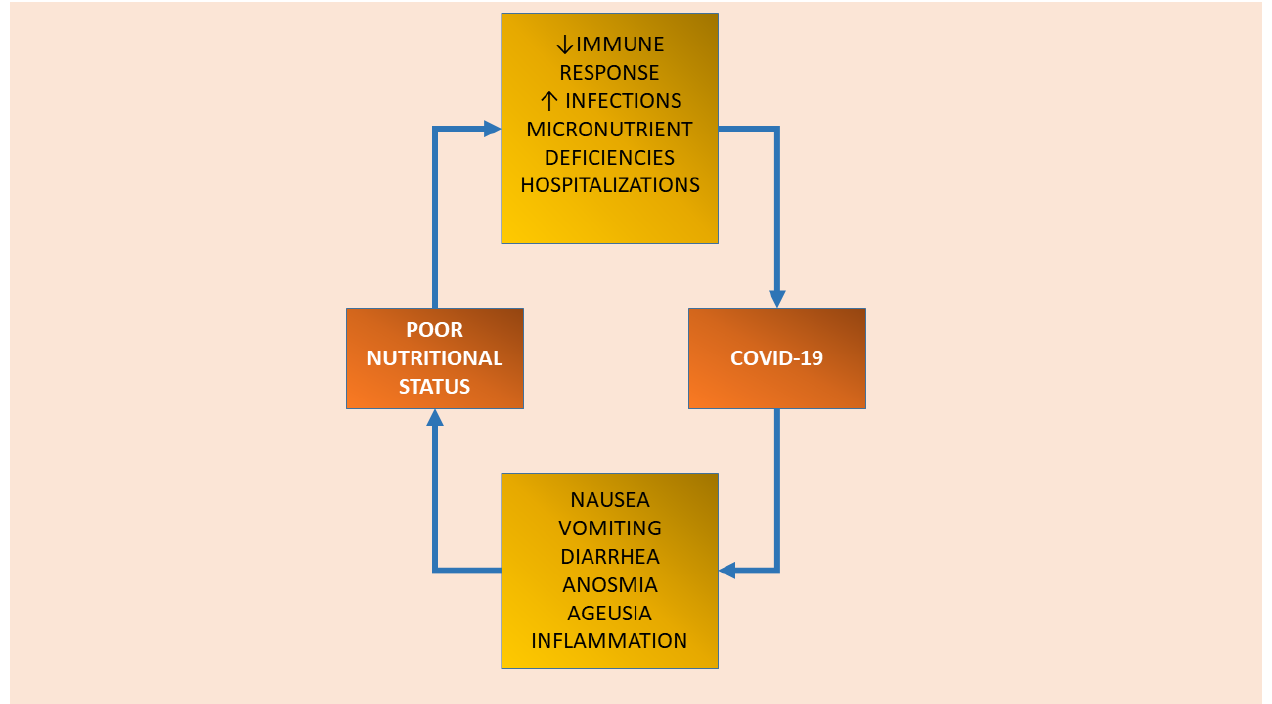
Figure 1. The bidirectional relationship between poor nutritional status and COVID-19 infection.